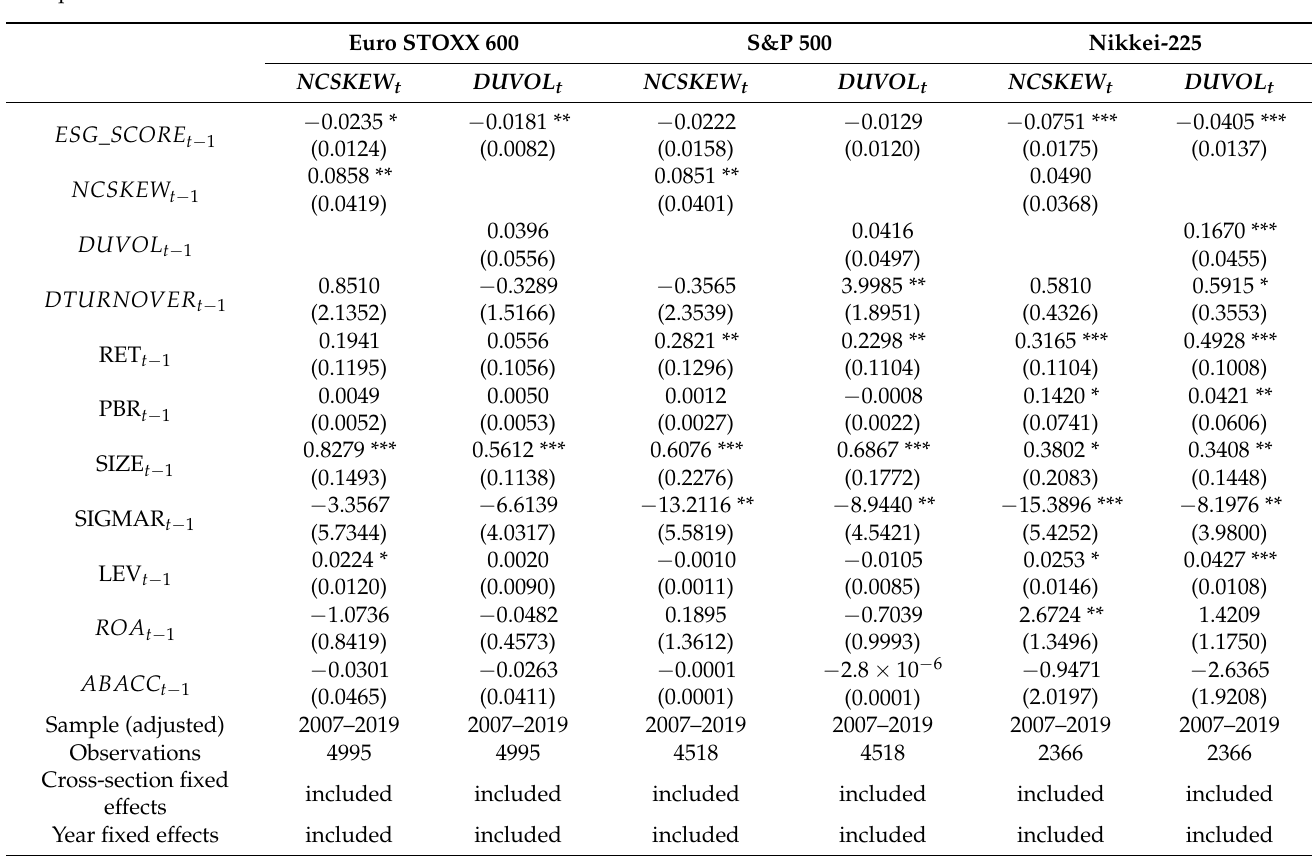
Table 6. Regression analysis on the effect of environmental, social, and governance disclosures on crash risk using dynamic panel